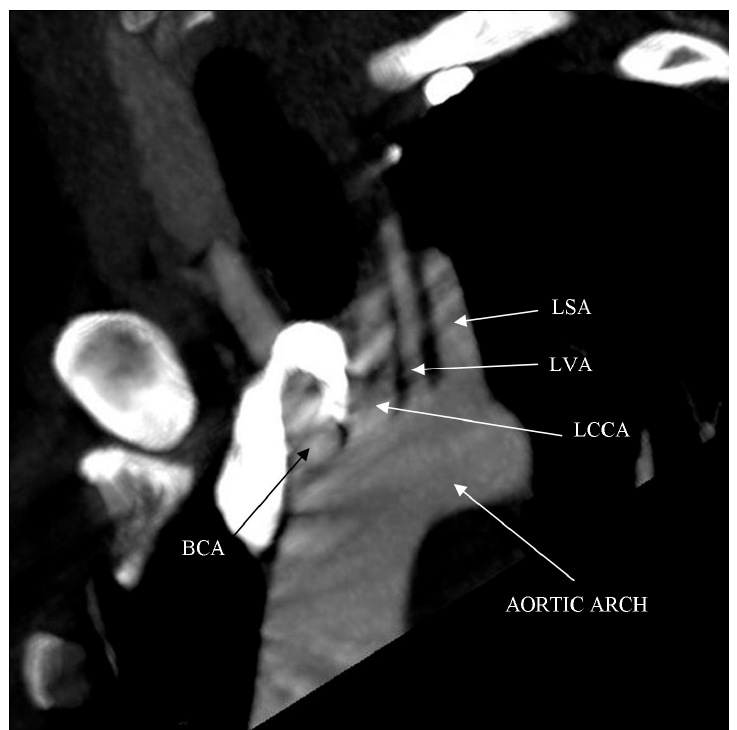
Figure 1. Right upper limb computed tomography angiography. MIP reconstruction. Candy cane view. Independent left vertebral artery ostium between the ostia of the left common carotid artery and the left subclavian artery (vascular anatomic variant). Int. J. Environ. Res. Public Health 2021 , 18 , x FOR PEER REVIEW